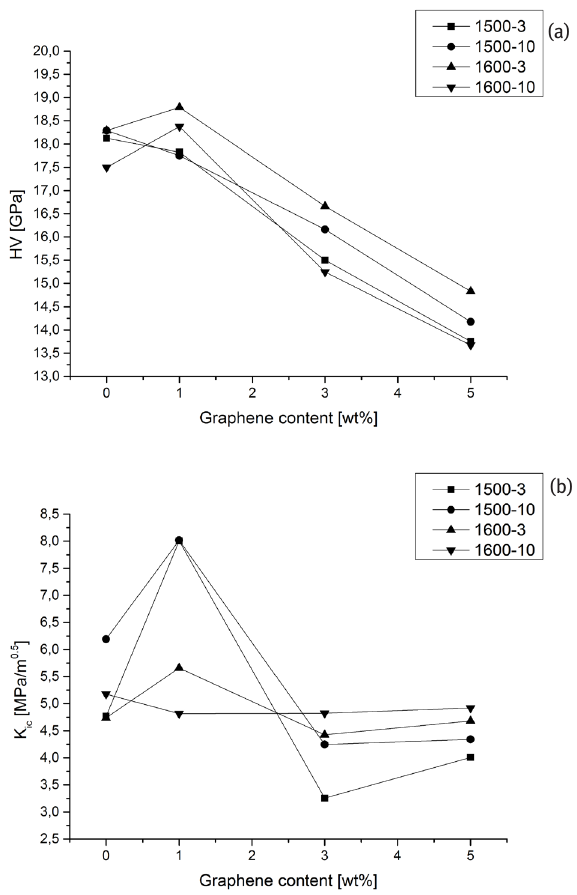
Figure 5 : Results of the mechanical analysis hardness (a) , and fracture toughness (b) on the different graphene concentration and sintering